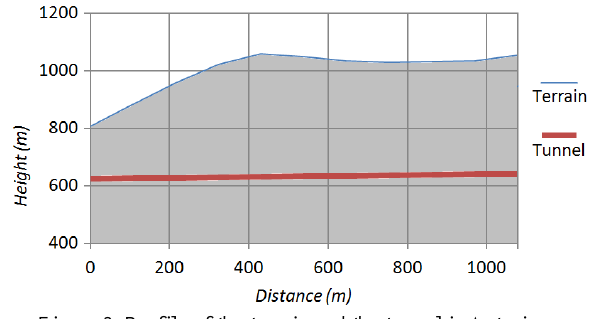
Figure 3. Profile of the terrain and the tunnel in Asturias.